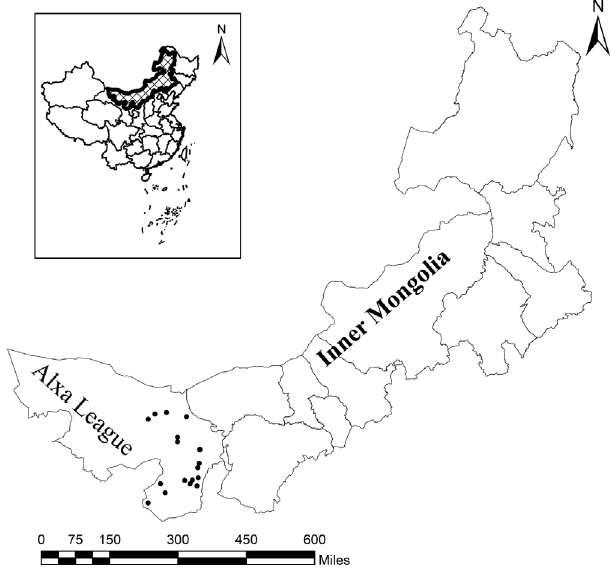
Figure 1. Location of the study area in Alxa League, Southwest Inner Mongolia, China. Sampling sites are marked by fi lled